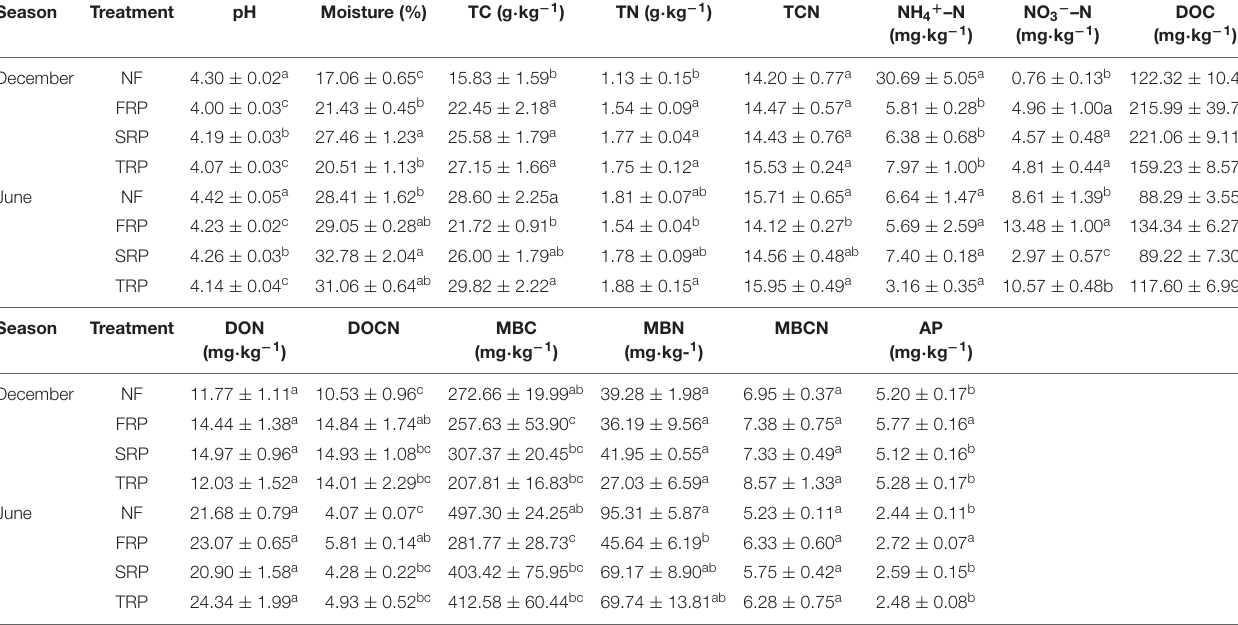
TC, total carbon; TN, total nitrogen; TCN, TC/TN ratio; DOC, dissolved organic carbon; DON, dissolved organic nitrogen; DOCN, DOC/DON ratio; MBC, microbial biomass carbon; MBN, microbial biomass nitrogen; MBCN, MBC/MBN ratio; AP, available phosphorus; NF, natural forest; FRP, first rotation plantation; SRP, second